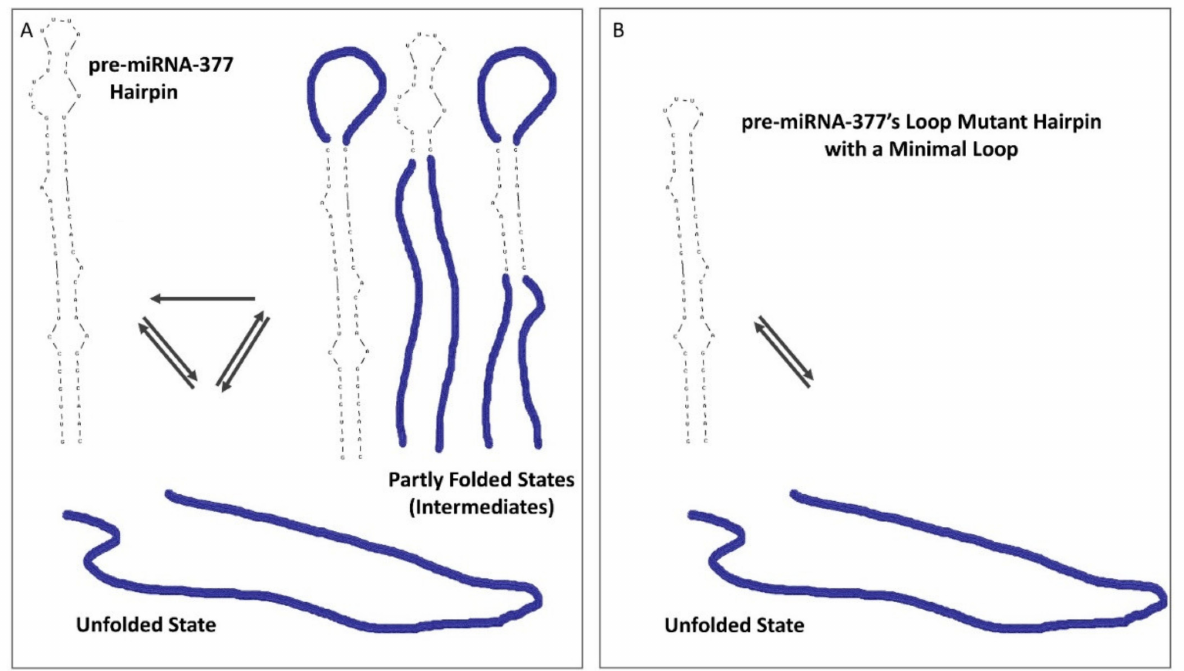
Figure 5. Model of pre-miRNA-377 unfolding and folding. ( A ) The illustrated folded state (hairpin) is the lowest free energy secondary structure of the pre-miRNA-377 predicted in UNAFold. Partly folded states (intermediates) occurring in type 2 and type 3 FDCs are drawn schematically (not predicted). ( B ) With a minimal 4 nt hairpin loop (loop mutant), only transitions without intermediates between the hairpin and the unfolded state are observed. The folded state of the loop mutant illustrates the lowest free energy secondary structure predicted in